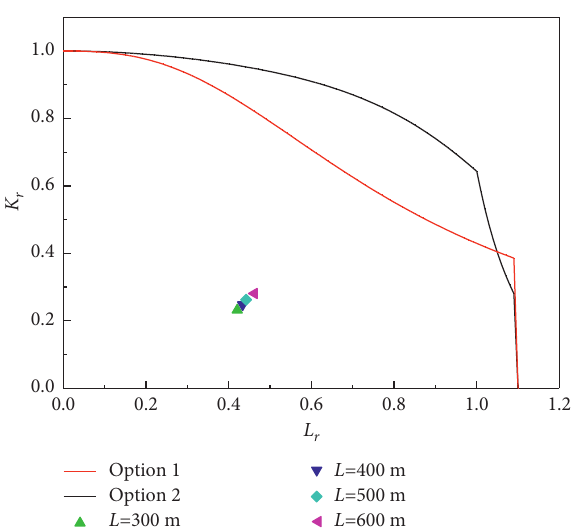
Figure 16: Effect of the riser length on the fracture performance of the riser.